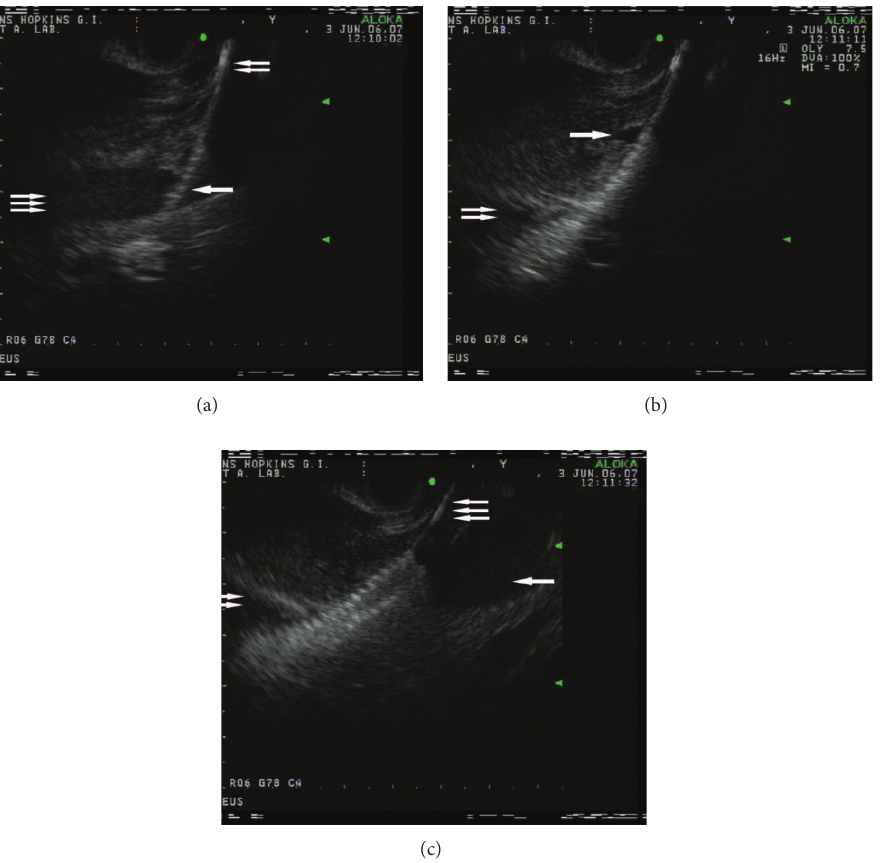
Figure 2: Endosonographic views during the stent deployment. (a) The stent (one arrow) delivery over the guidewire (two arrows) into the hepatic vein (three arrows). (b) Deployment of the stent; the proximal end of the stent inside the hepatic vein (one arrow) and the distal end of the stent inside the portal vein (two arrows). (c) The stent fully deployed with its proximal end inside the hepatic vein (one arrow) and the distal end inside the portal vein (two arrows); the guidewire (three arrows) (images curtsey of